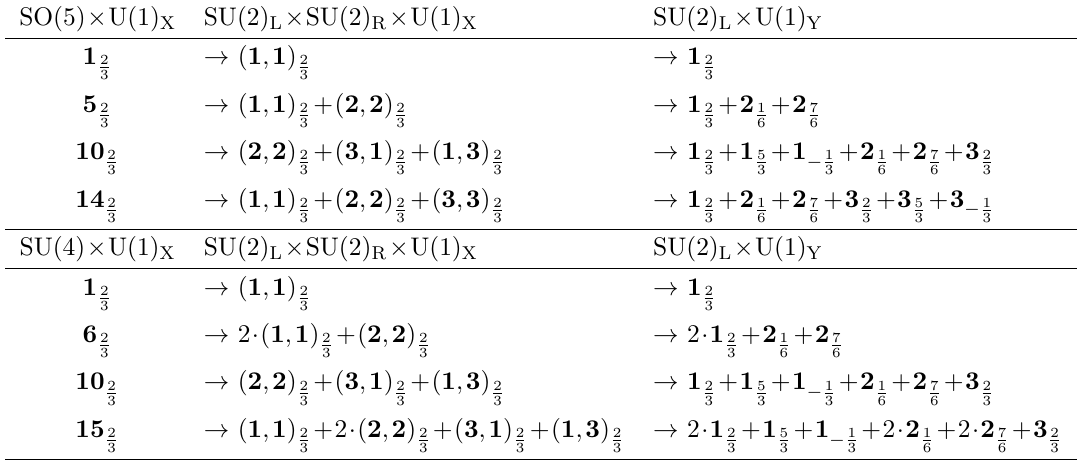
Table 5 . The decomposition of Sp(4) × U(1) X ’ SO(5) × U(1) X irreps and SU(4) × U(1) X irreps under SU(2) L × SU(2) R × U(1) X . All partners have X = 2 / 3 . In the last column Y = T 3 include the 4 irreps since they present phenomenological problems [79] and cannot be realized in 1 / 6 the UV completions [10, 58] under